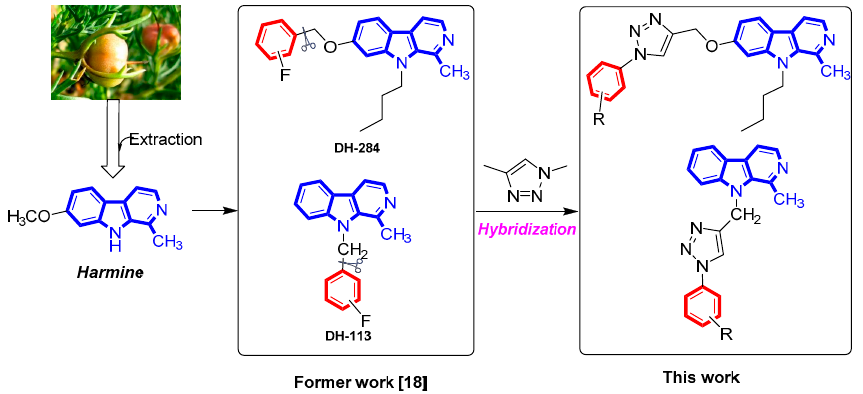
Figure 1. Designed strategy of aryl-1,2,3-triazole- β -carboline hybrids.